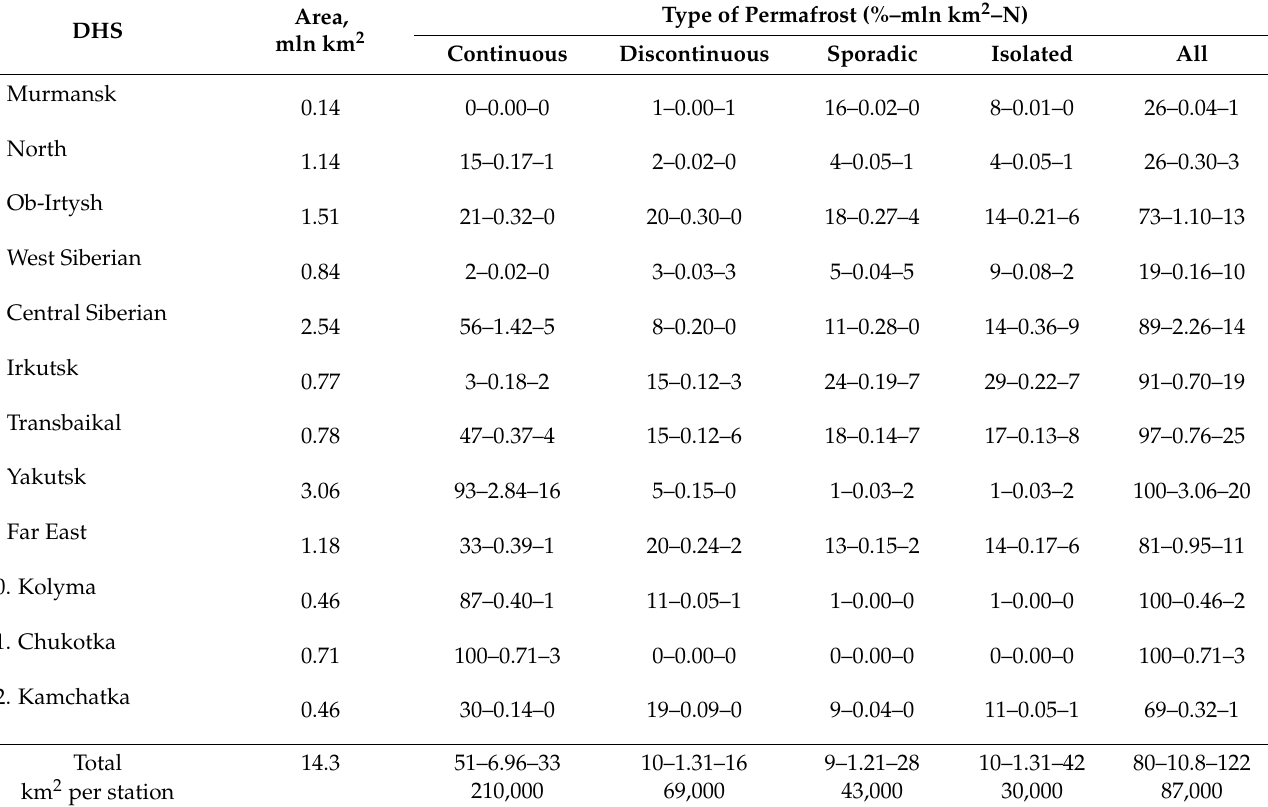
Table 1. Distribution of permafrost type (%) in the departments of Russian Hydrometeorological Service (DHS) located in a permafrost zone and the number of meteorological stations monitoring ground temperature at 0.8–3.2 m depth (N) in 2019.